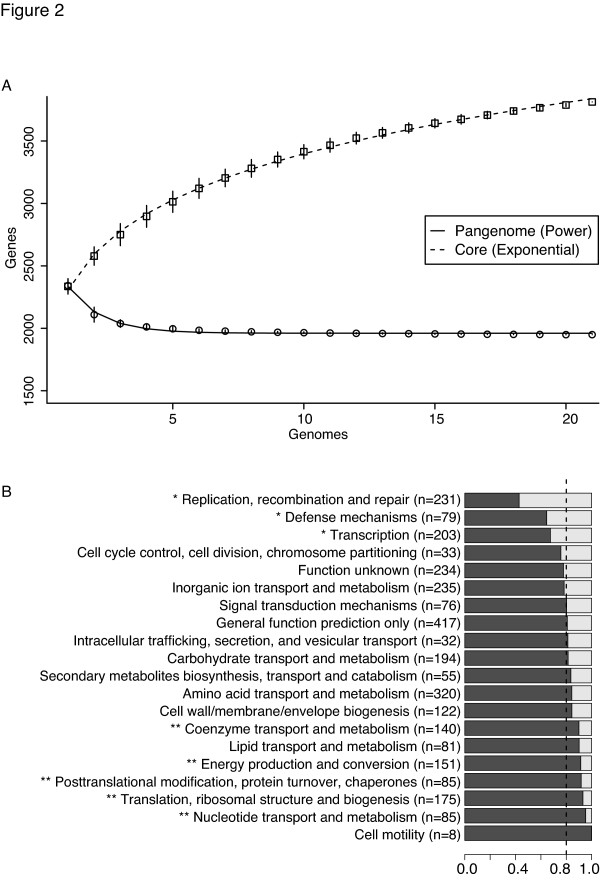
Commensal S. epidermidis has an open pan-genome. Pan-genome size of S. epidermidis. (a) Gene accumulation curves for pan-genome (squares) and core-genome (circles) as a function of genomes sequenced (N). Error bars are ±1 standard deviation for the 100 simulations. Core gene data are fit by: y = a·exp-N/b + c. Pan-genome data are fit by: y = a·Nb + c. (b) Partitioning of core and variable genes for each COG. COGs significantly enriched (P < 0.05, Fisher exact test) in variable or core genes are marked with single and double asterisks, respectively. The dashed line indicates the expected proportions.